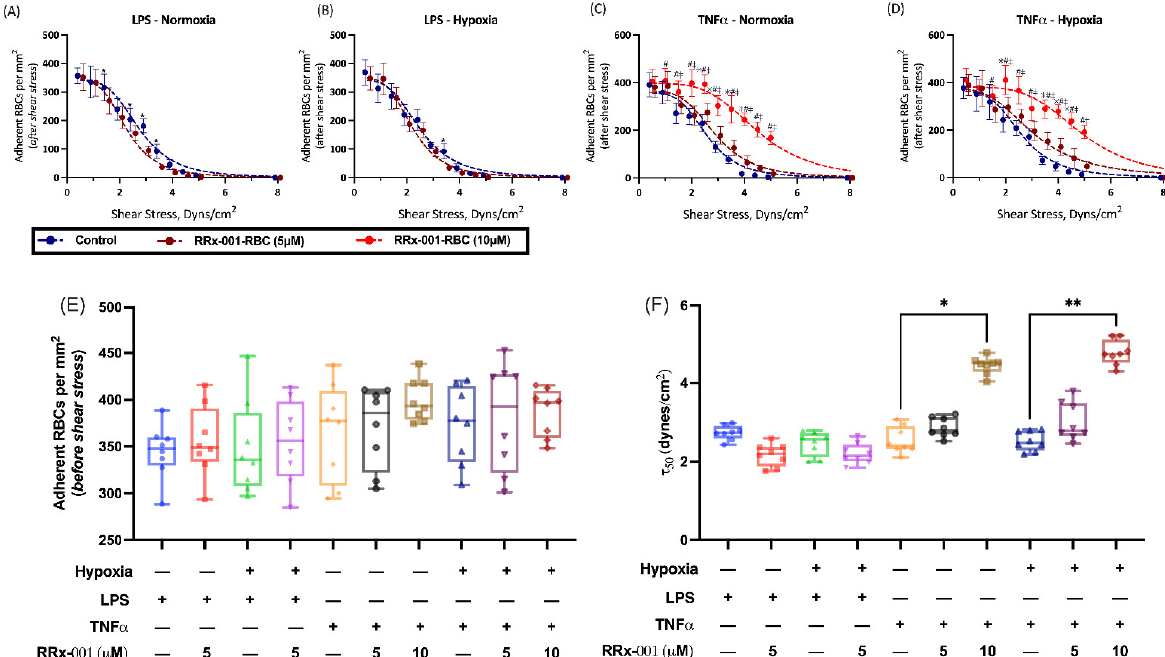
Figure 2. RRx-001 Induces Increased RBC Adhesion to the Endothelium. Adherent RBCs per mm 2 versus Shear Stress were fit to an inverse sigmodal curve and are shown for untreated and RRx-001 treated cells at 5 and 10 mg/kg under ( A ) LPS-induced inflammation and Normoxia, ( B ) LPS-induced inflammation and hypoxia, ( C ) TNF α induced inflammation and normoxia, ( D ) TNF α induced inflammation and hypoxia (* p < 0.05 Control vs. RRx-001 5 µ M, # p < 0.05 Control vs. RRx-001 10 µ M, ‡ p < 0.05 RRx-001 5 µ M vs. RRx-001 10 µ M). Fit parameters for inverse sigmoidal curves, namely ( E ) Adherent RBCs per mm 2 (before application of shear stress), and ( F ) τ 50 , or the minimum shear stress for 50% disassociation of RBCs, are shown for the same parameters (* p < 0.03, ** p < 0.002, **** p < 0.0001 for Holm-Sidak multiple comparisons).